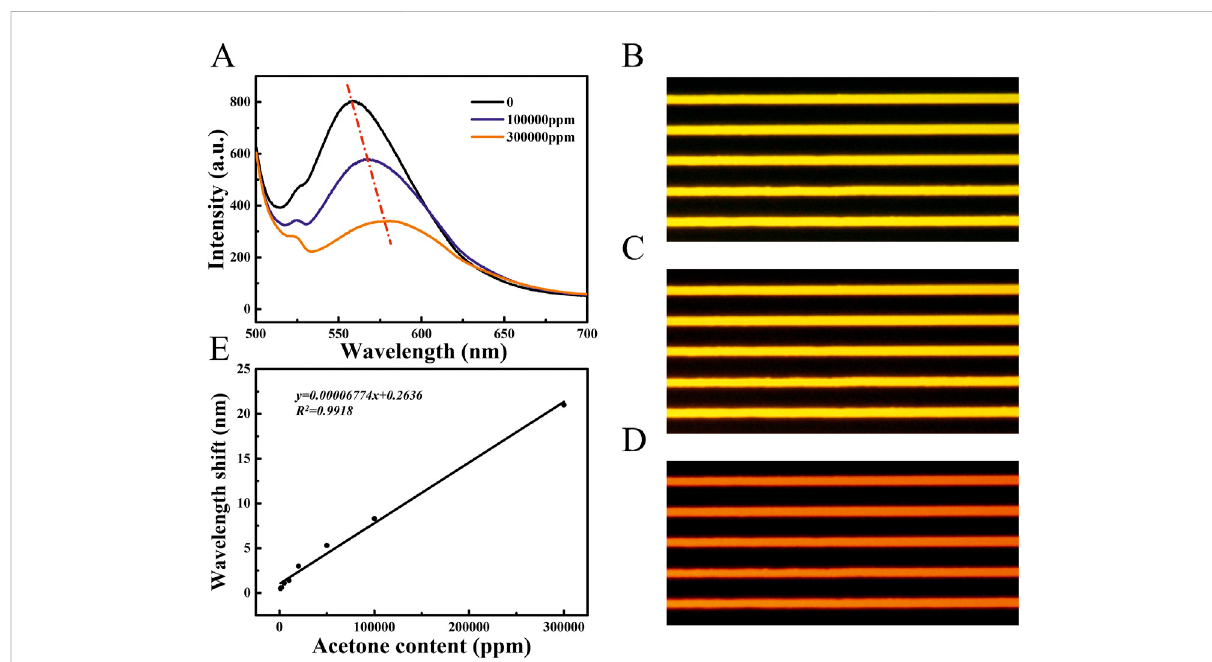
FIGURE 2 (A) Fluorescence spectra of PS/TPMN samples in the gaseous atmosphere at 0, 100000 ppm, and 300000 ppm acetone concentrations. Compared with the acetone concentration of 0, the PS/TPMN samples were red-shifted by 8.3 nm and 21.0 nm in the atmosphere containing 100,000 ppm and 300,000 ppm of acetone vapor, respectively, and the fl uorescence intensity was reduced by 22.89 ± 0.81%, and 53.72 ± 1.66%, respectively (B) Fluorescence photographs of PS/TPMN samples in the air; (C) Fluorescence photographs of PS/TPMN samples in acetone atmosphere at 100000 ppm (D) Fluorescence photographs of PS/TPMN samples in 300000 ppm acetone atmosphere; (E) Fluorescence photographs of PS/TPMN samples red-shifted in acetone vapor atmosphere at 1,000 – 300000 ppm, and the degree of red-shift showed a good linear relationship with acetone vapor